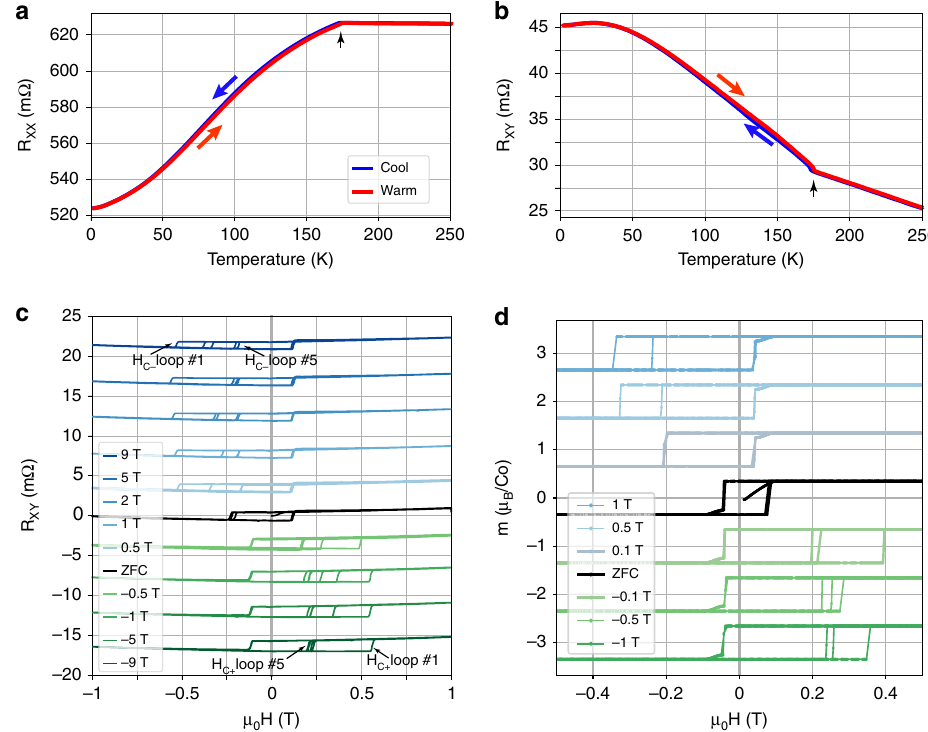
) ( a ) and transverse ( R ) ( b) xx xy